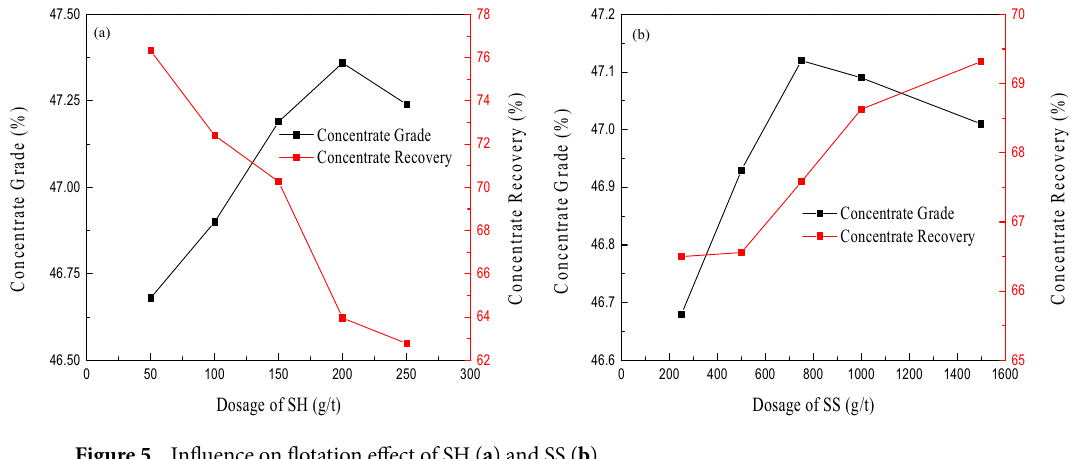
Figure 5. Influence on flotation effect of SH ( a ) and SS ( b